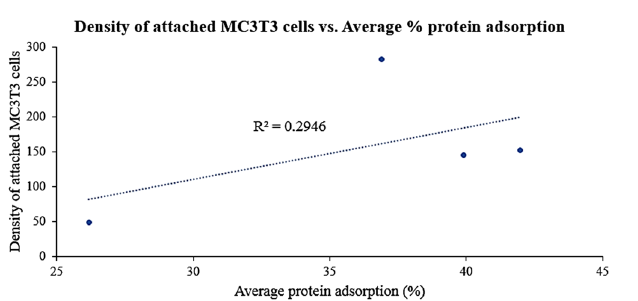
Figure 5. Density of attached MC3T3-E1 cells plotted as a function of average % adsorption of all three culture medium proteins: Fibronectin, Vitronectin, and